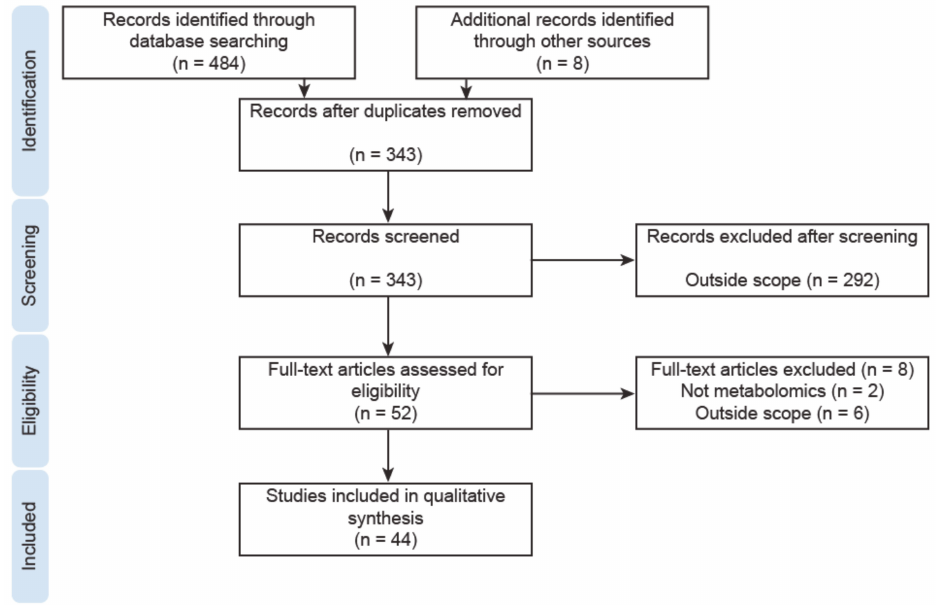
Figure 2. Study flow